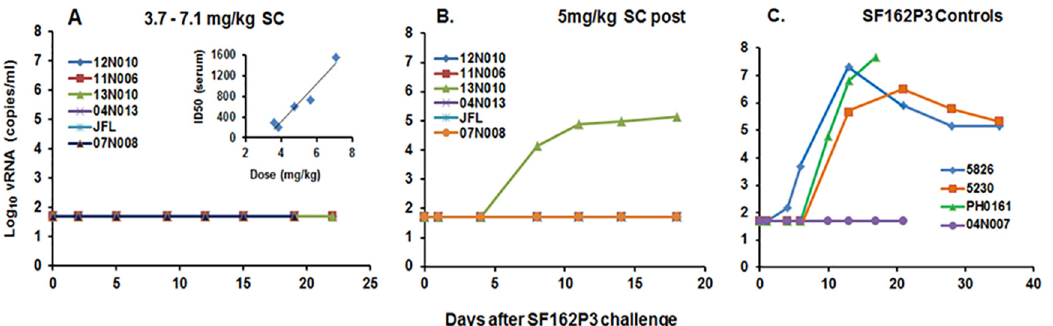
Fig 2. Protection by SC-administered plant-derived PGT121 against intravaginal SHIVSF162P3 challenge in rhesus macaques as measured by log 10 vRNA (copies/ml of plasma). (A) Protection in 6/6 macaques that received 3.7 – 7.1 mg/kg doses of PGT121 given 24 hr prior to SHIV SF162P3 challenge. Insert shows a linear correlation between ID50 and dose (3.5 – 7.1 mg/kg) at 24 hr; ID50 values at doses of 3.86, 4.7 and 5.6 mg/kg were 1:202, 1: 612 and 1: 738 respectively). (B) Protection in 5/6 macaques administered 5 mg/kg SC immediately after SF162P3 challenge. (C) Four control macaques received no passive bnAb. Application of Fisher ’ s Exact Test showed that protection of animals given PGT121 prior to challenge (panel A) compared to the control group (panel C) was statistically significant (p = 0.03), while protection of animals given PGT121 after challenge was not (p =